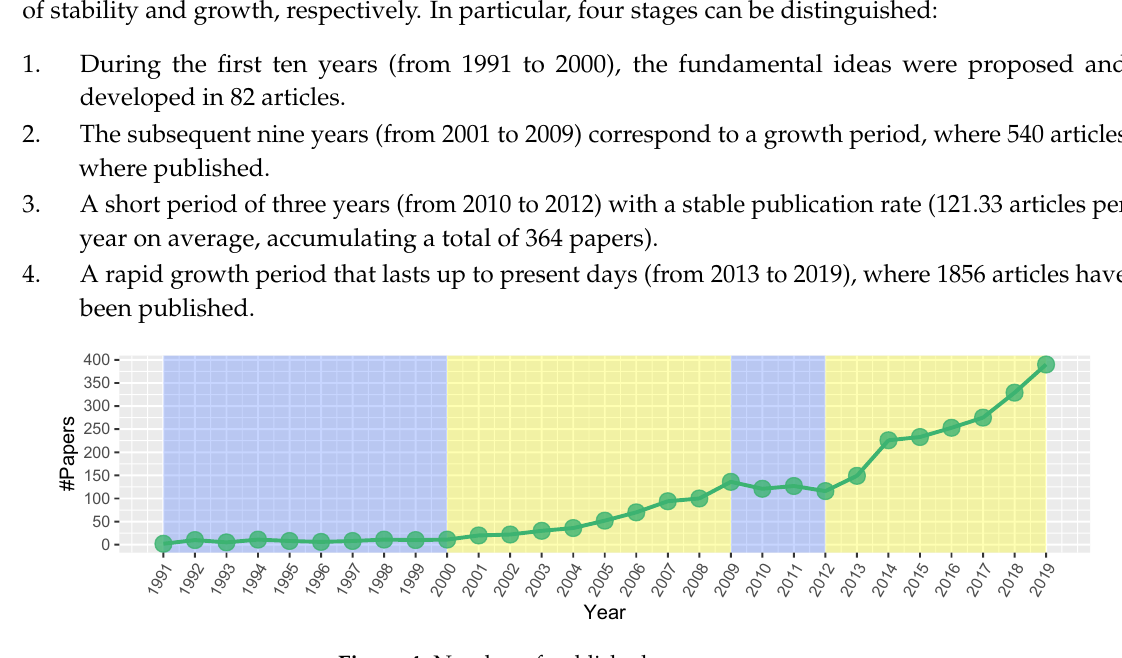
Figure 4. Number of published papers per